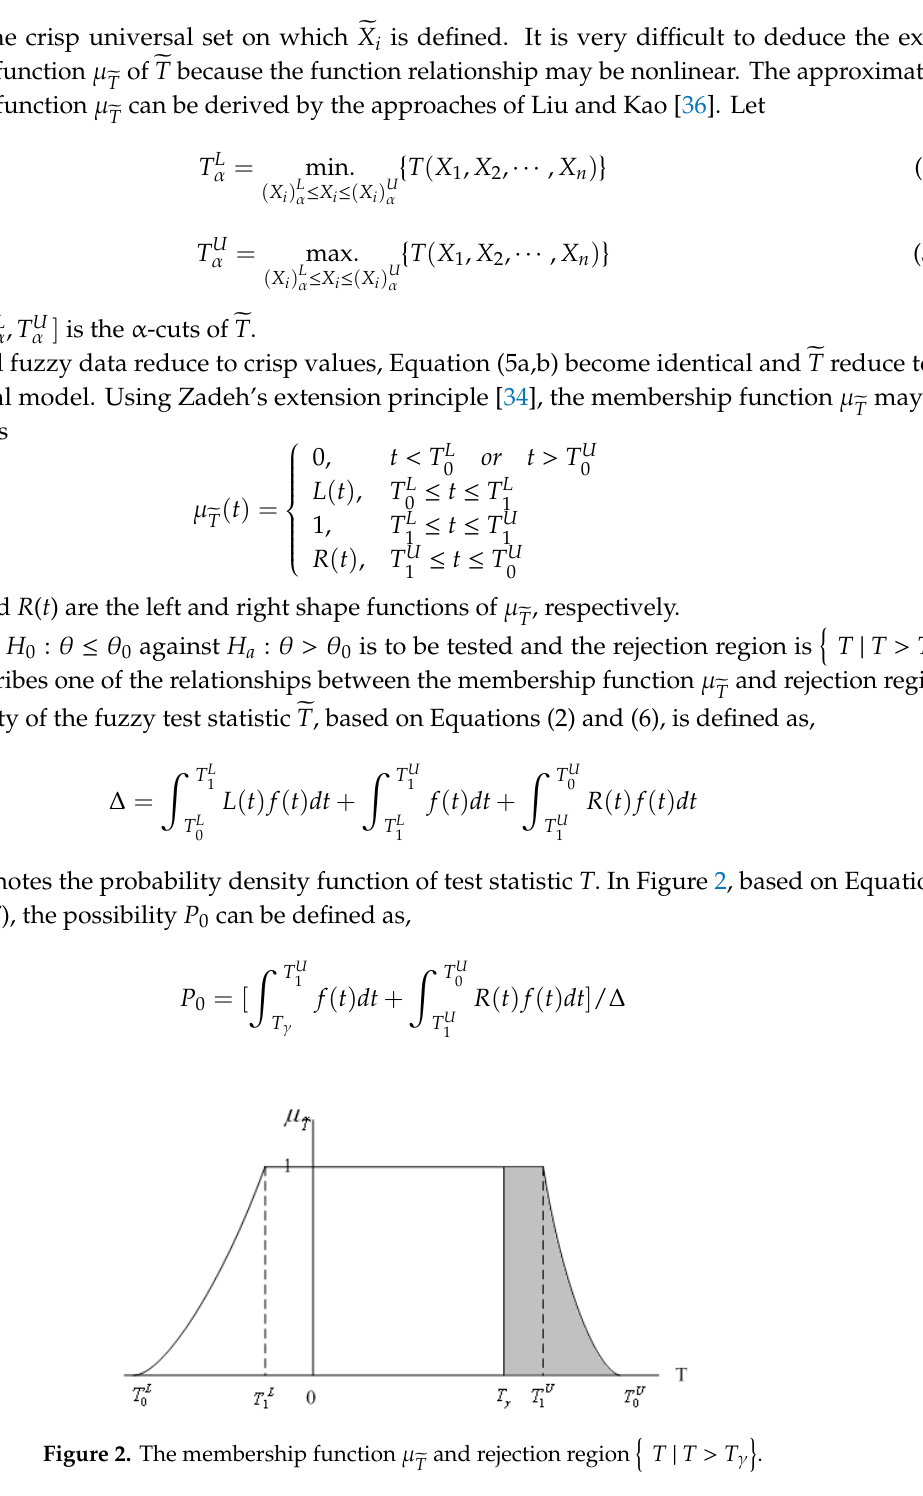
Figure 2. The membership function